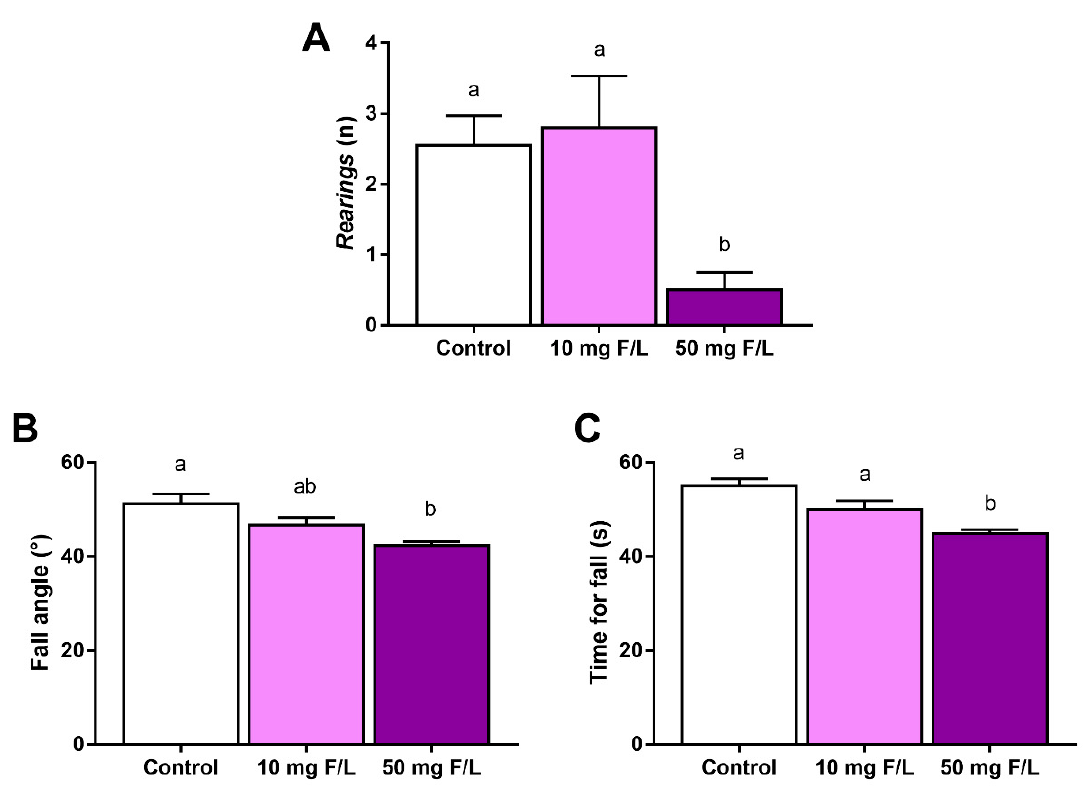
Figure 3. Effects on offspring behavior after 42 days of fluoride exposure (10 mg F/L or 50 mg F/L, n = 10/group) during the gestational and lactation periods. The number of rearings ( A ), fall angle in degrees ( B ), and time for fall in seconds ( C ). The results are expressed as the mean ± standard error of the mean (SEM). One-way ANOVA and Tukey’s post hoc test, p < 0.05. Identical lowercase letters indicate the absence of a statistical difference.